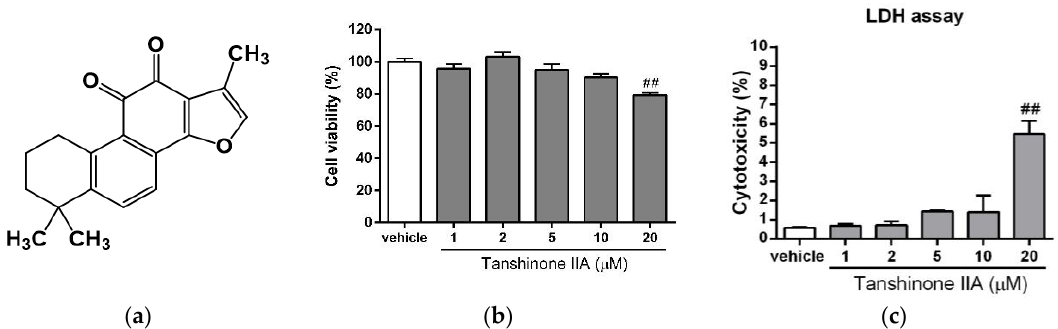
Figure 1. Effects of tanshinone IIA on HepG2 cell viability. ( a ) The chemical structure of tanshinone IIA. HepG2 cells were treated with vehicle (0.1% DMSO) or tanshinone IIA (1,2,5,10, and 20 μM) for 24 h. ( b ) Cell viability was measured using an MTT assay. ( c ) Cytotoxicity was measured using LDH release assay. The data represent the mean ± SD of three independent experiments. ## p < 0.01 indicates significant differences compared to the vehicle-treated cells.